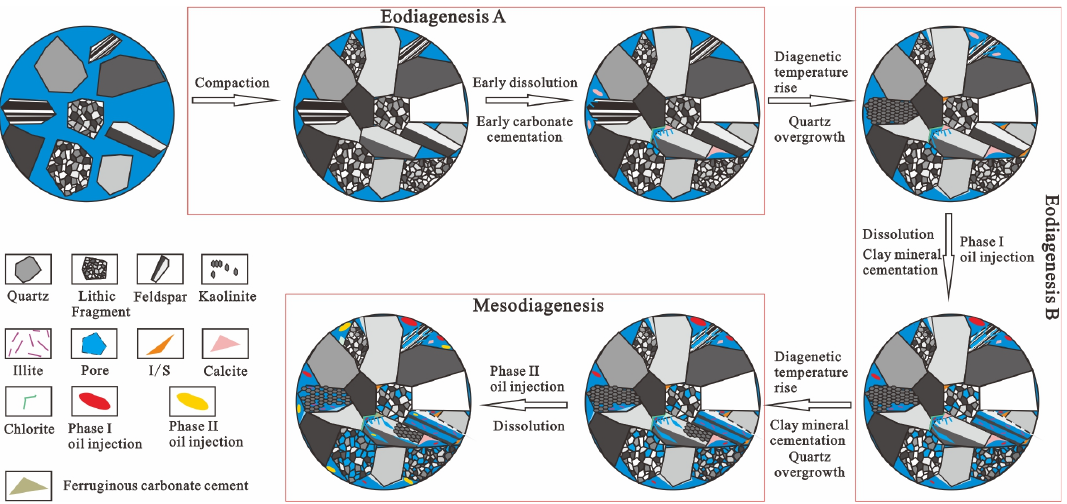
Figure 14. Schematic diagram showing the diagenetic evolution of tight sandstones in the Chang-7 Member of Ordos Basin